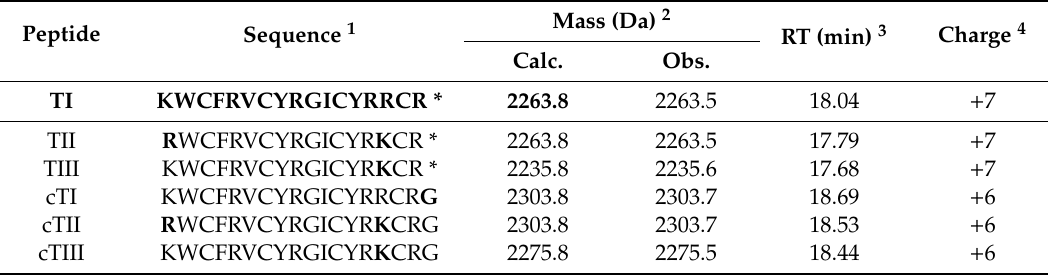
Table 1. The sequence and physicochemical properties of tachyplesin I–III (TI-TIII) and their cyclic analogues